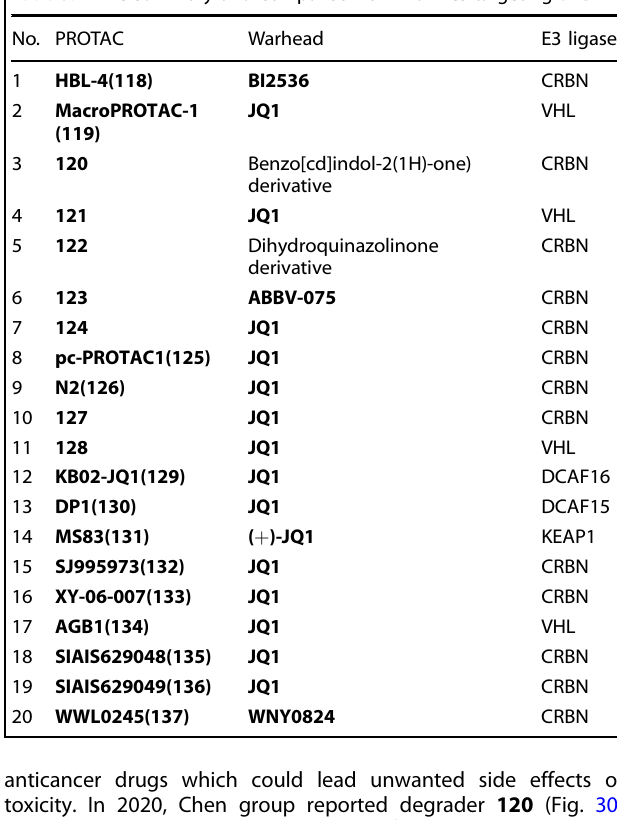
Table 5. The summary and comparison of PROTACs targeting